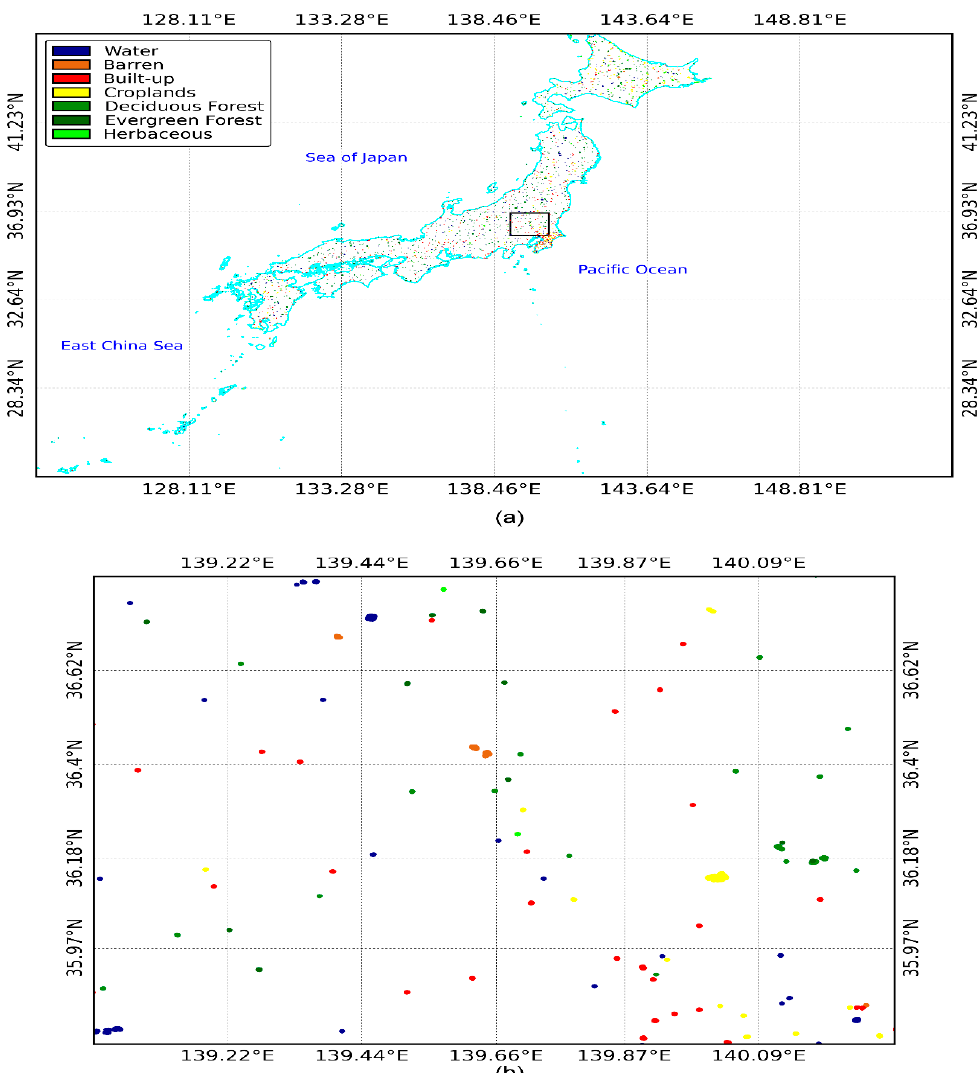
Figure 2. The distribution of reference (training and validation) data: ( a ) display of the national territory; ( b ) zoomed in over the black polygon region in ( a ) showing the density of the reference points. The national boundary is based on the Global Administrative Areas database (GADM) Version 2.8, November 2015.